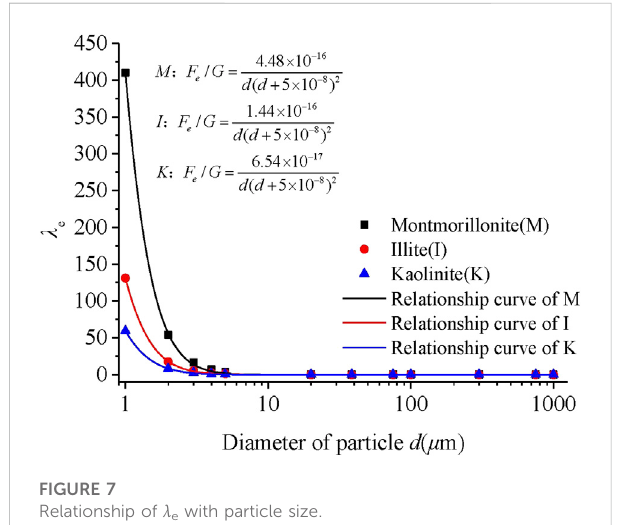
FIGURE 7 Relationship of λ e with particle size.